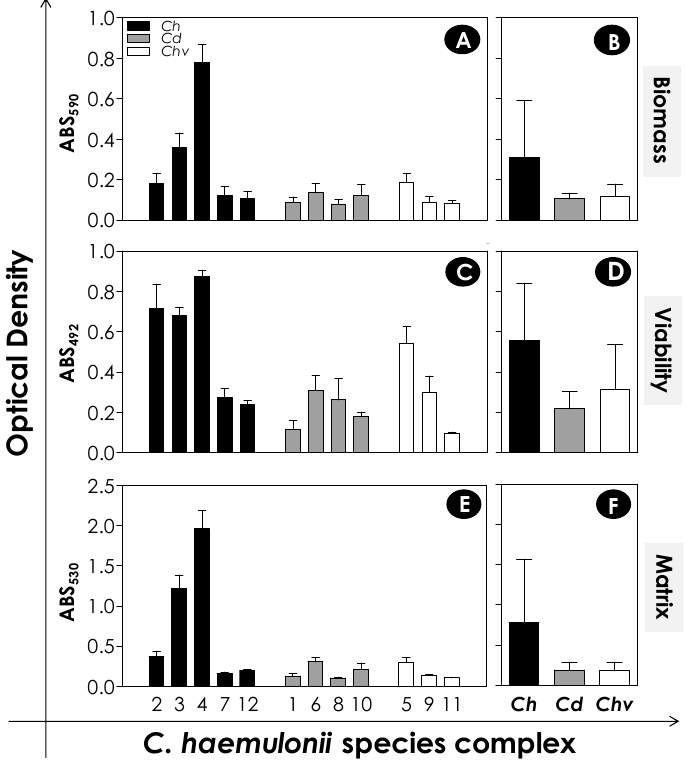
Figure 1. Biofilm formation by the C. haemulonii species complex on polystyrene surface. Yeasts (200 µL containing 10 6 cells) were placed to interact with polystyrene for 48 h at 37 °C. Afterwards, the systems were processed to detect fungal biomass by crystal violet incorporation in methanol-fixed biofilms at 590 nm, cell viability by the reduction of 2,3-bis (2-methoxy-4-nitro-5-sulfophenyl)-5-[(phenylamino) carbonyl]-2H-tetrazolium hydroxide (XTT) in formazan at 492 nm, and extracellular matrix by staining non-fixed biofilms with safranin at 530 nm. The results were expressed as absorbance (ABS) values per clinical isolate studied ( A , C , and E ) and mean per fungal species ( B , D , and F ). The results are shown as mean ± standard deviation of three independent experiments. The numbers on the X-axis of graphs represent each of the 12 clinical isolates of the C. haemulonii species complex studied, in which Ch means C. haemulonii , Cd means C. duobushaemulonii, and Chv means C. haemulonii var. vulnera .